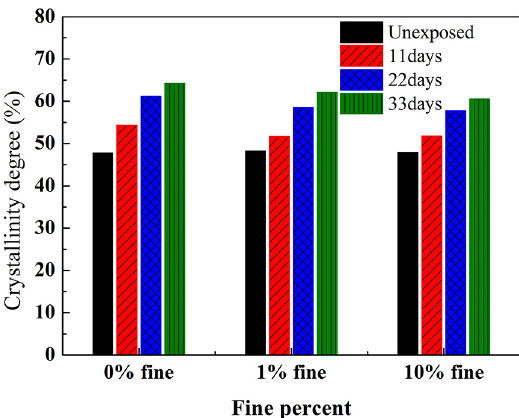
Figure 6. Crystallinity degree of neat UHMWPE and their compounds with iron ore fine after UV irradiation. The accuracy of the data was obtained for selected samples and is ± 2%.